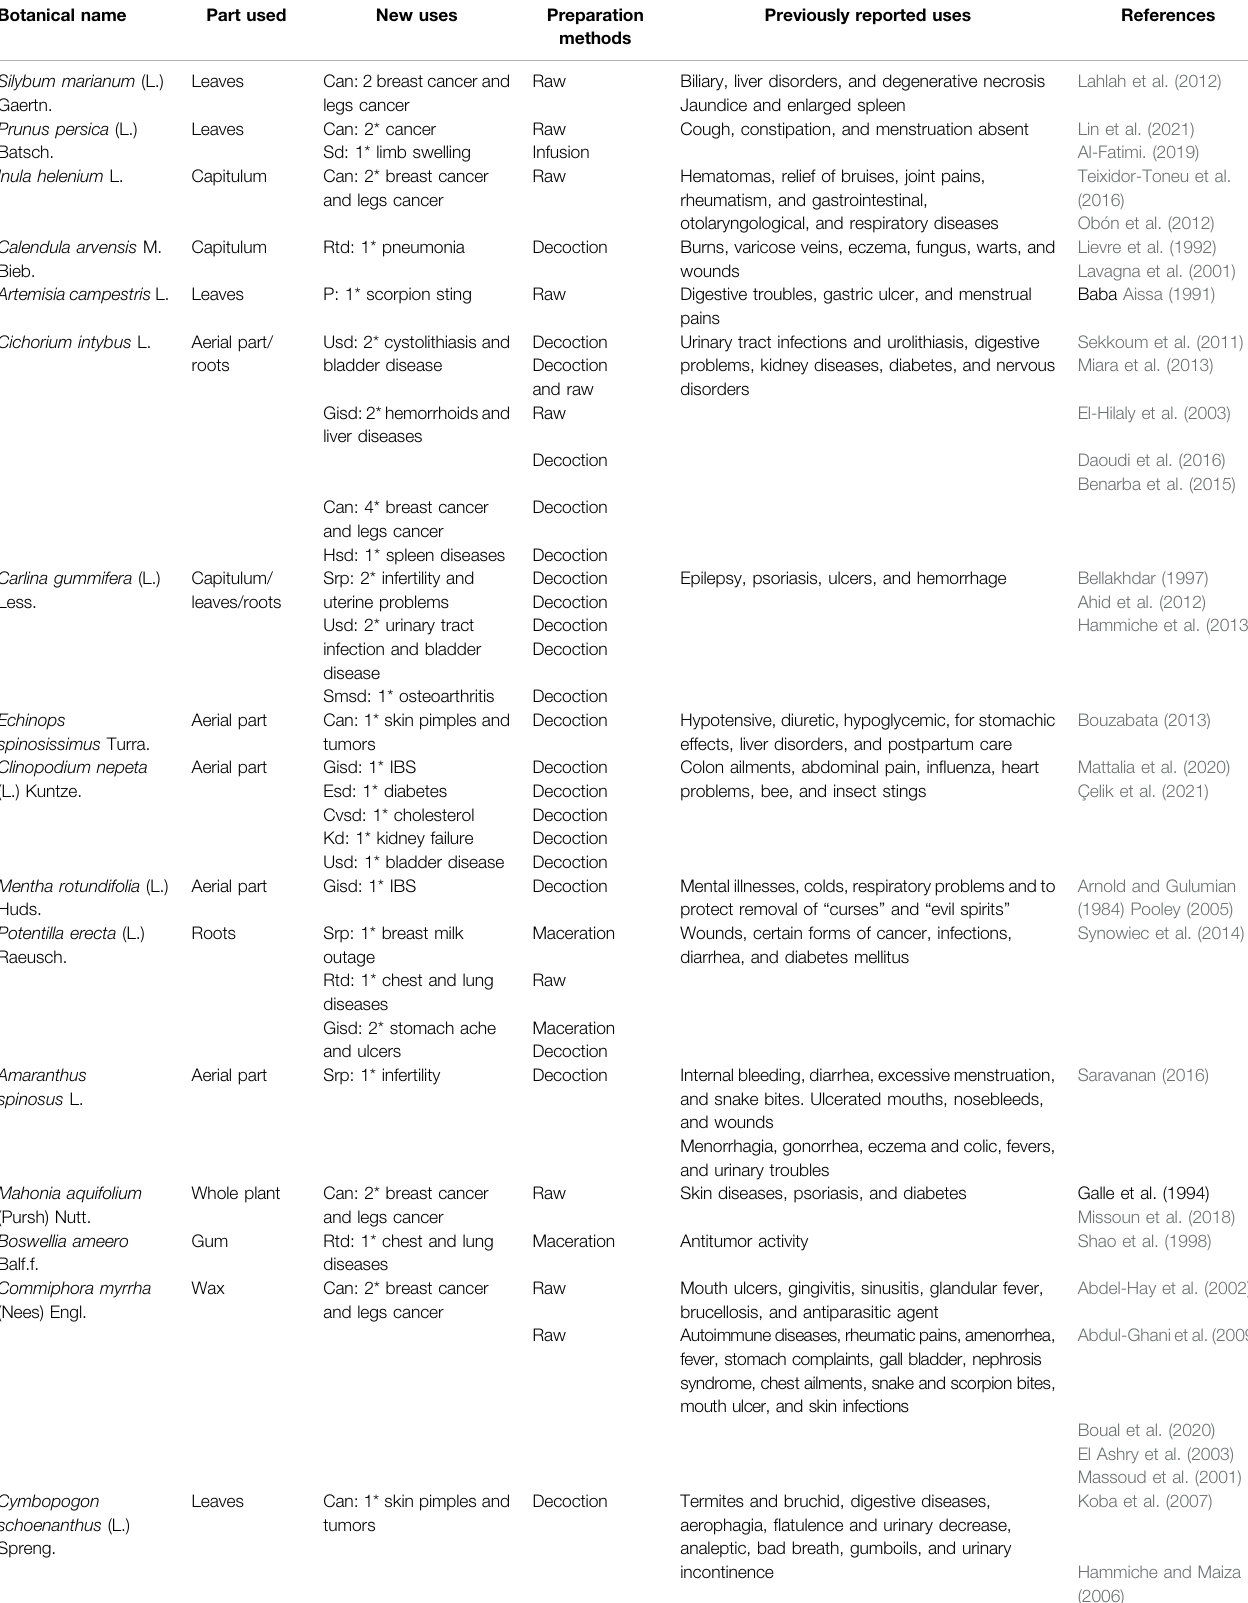
TABLE 4 | List of new therapeutic uses recorded in Algeria (West-Kabylia-Sahara). Botanical